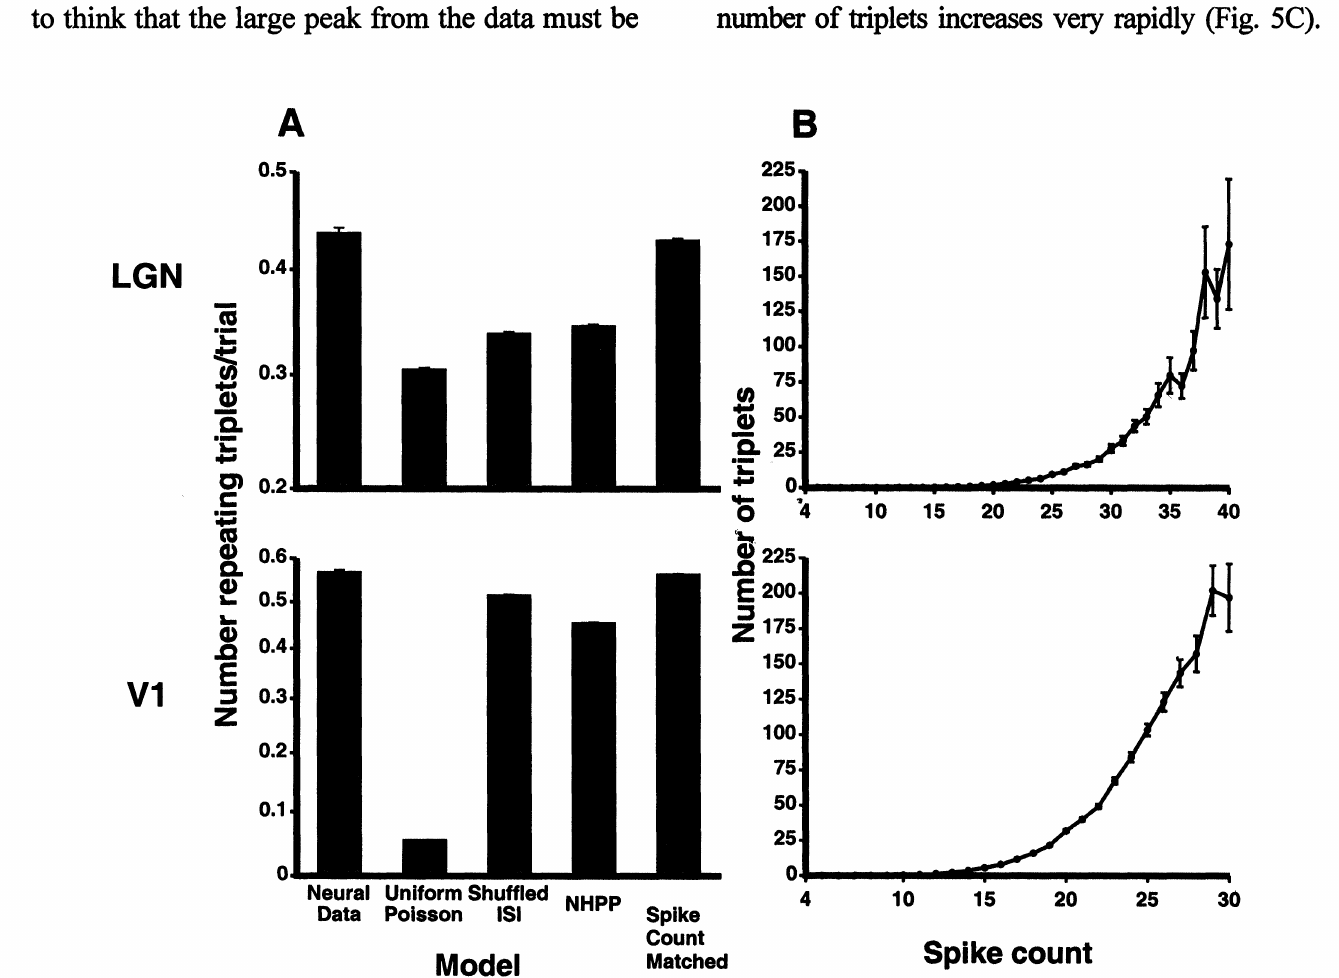
Fig. 5: A. The number of repeating triplets seen in the data (left bar) and four models: the uniform Poisson model, the interval shuffling model, the nonhomogeneous Poisson model, and the spike count matched model. The numbers of repeating triplets generated by the spike count matched model are indistinguishable from the number found in the data. The numbers generated by the other 3 models are significantly (p < 0.001) different than those found in the data. B. Relation of the number of triplets to spike count. The numbers of triplets increases nonlinearly at all spike counts. If the variability of the responses is underestimated the number of triplets predicted will be underestimated because the number of triplets added by a high spike count will not be completely compensated by the number lost at the corresponding low spike